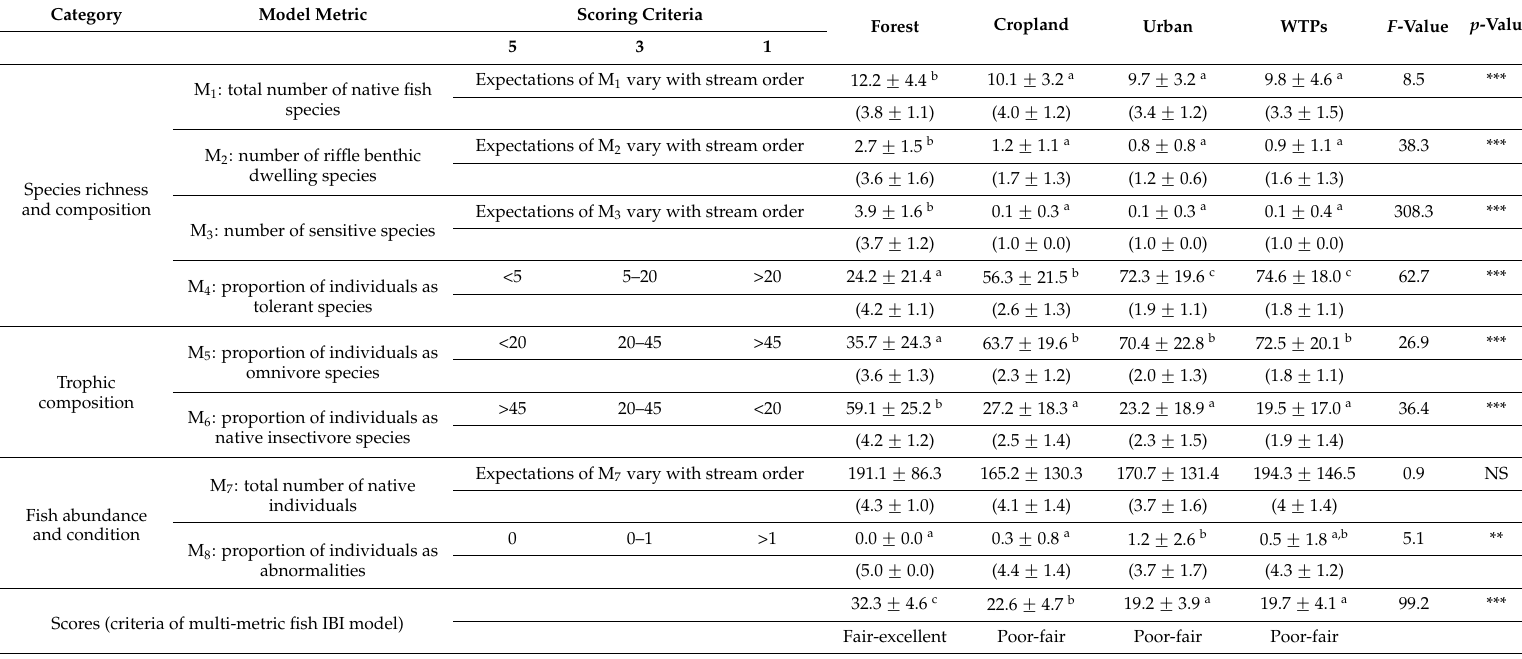
Table 3. Model metrics and scoring criteria of the multi-metric fish index of biological integrity values according to type of land. The superscript letters indicate significant differences among the four regions on Scheffe’s post-hoc